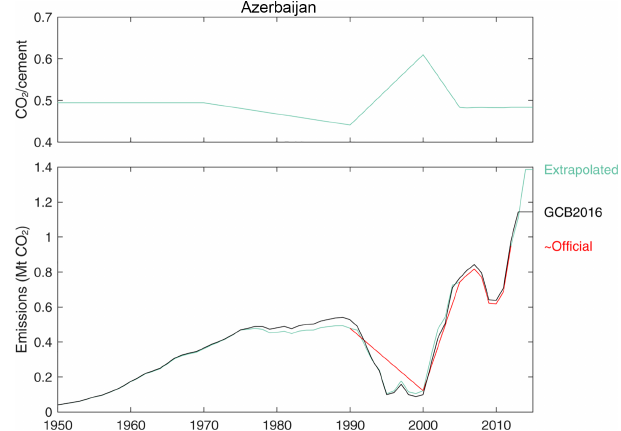
Figure D11. Revised cement emissions for Armenia.